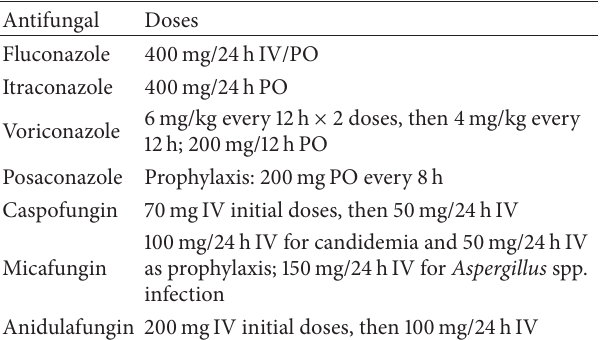
Table 5: Dosages of administrations of antifungal agents for empirical treatment of febrile